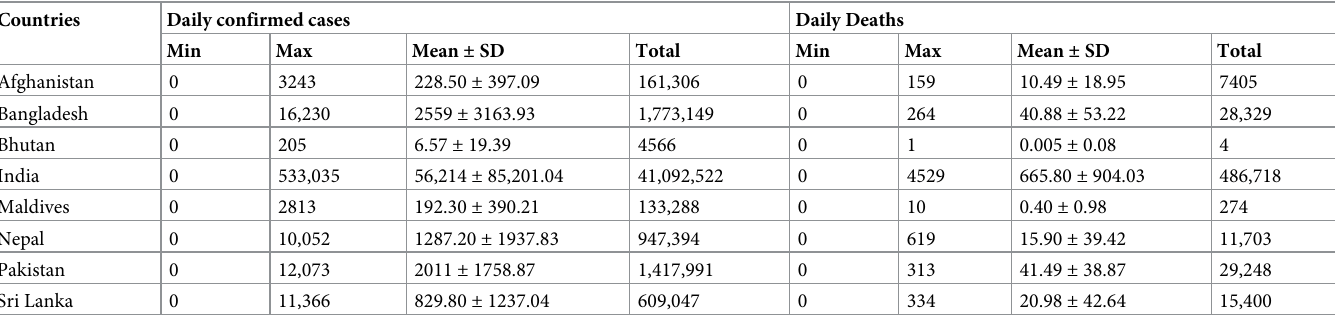
Table 1. Summary statistics of COVID-19 confirmed cases and deaths for SAARC countries till January 29, 2022.